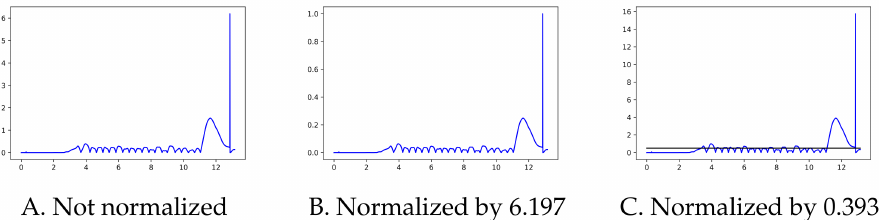
Figure A3. A participant in the HC group, fast walk experiment. In blue, absolute differences of two consecutive smoothed values of the pelvis rotation angle: ( A ). No normalization, ( B ). Divide by maximum value, ( C ). Divide by the percentile 90 value. In black, threshold of 0.5.